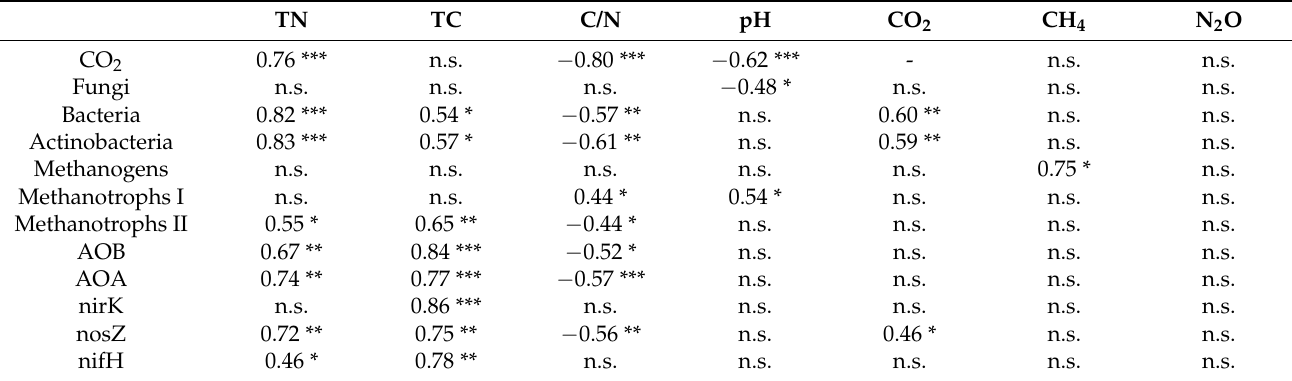
Table 4. Pearson’s correlation matrix of deadwood chemical parameters (TN, TC, C/N, and pH), maximum values of GHGs (CO 2 , CH 4 , and N 2 O) production, and the microbial group abundances measures in deadwood cores from the different decay classes. Only significant Pearson correlation coefficients (r-values) are